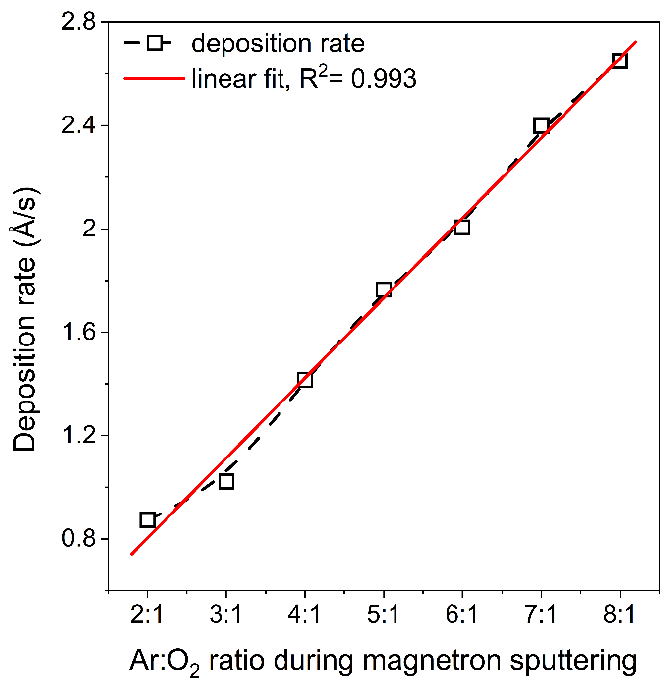
Figure 1. Dependence of the deposition rate of vanadium oxides thin films on the Ar:O 2 gas ratio during magnetron sputtering.